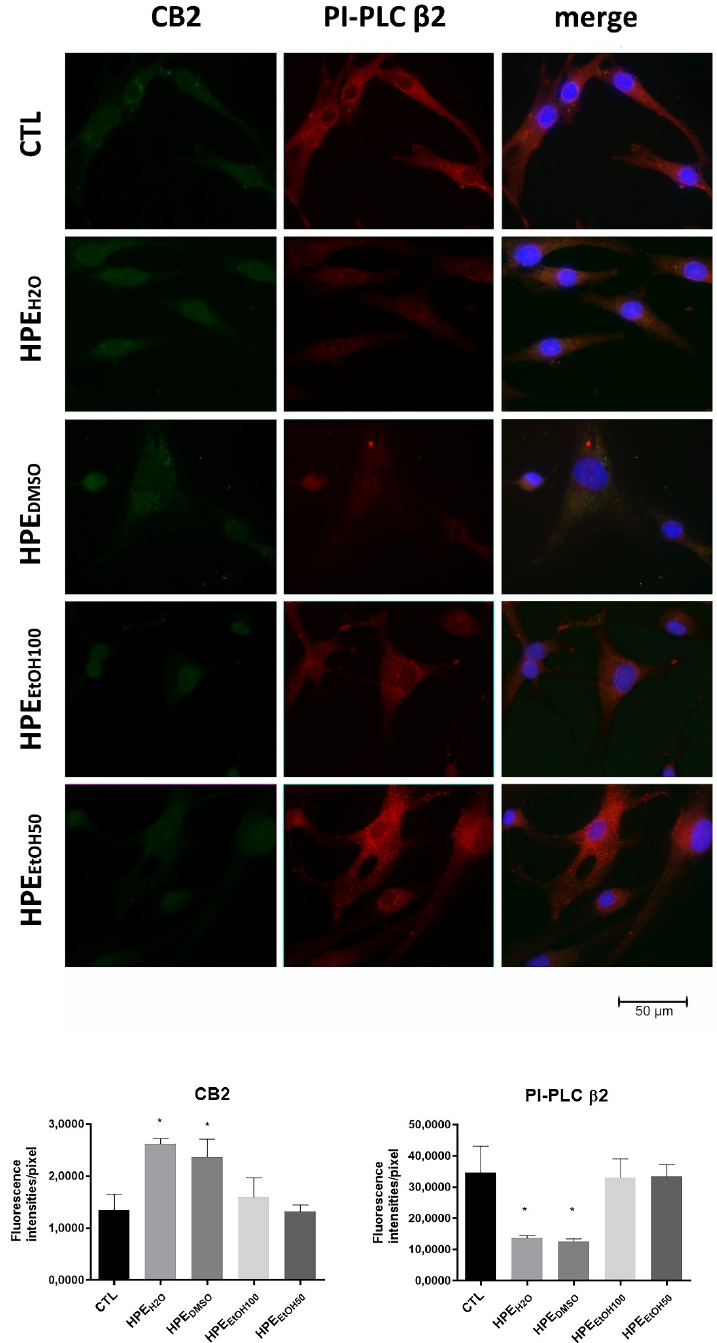
Figure 4. E ff ects of all HPE extracts on CB2 receptor and PI-PLC β 2 protein production. Upper Figure 4. Effects of all HPE extracts on CB2 receptor and PI-PLC β2 protein production. Upper panel: panel: Cells were treated with 0.1 mg / mL of Harpagophytum procumbens root extract (HPE) dissolved Cells were treated with 0.1 mg/mL of Harpagophytum procumbens root extract (HPE) dissolved in in deionized water (HPE H2O ), DMSO (HPE DMSO ), 100% v / v EtOH (HPE EtOH100 ), and 50% v / v EtOH (HPE EtOH50 ), for 24 h and then, analyzed by immunofluorescence using anti-CB2 and anti-PI-PLC β 2 primary antibodies and Alexa Fluor 488 (green, CB2) and Alexa Fluor 568 (red, PI-PLC β 2) secondary antibodies, respectively. Nuclei were stained with DAPI (original magnification 40 × ). Lower panel: The pixel intensities in the region of interest were obtained by ImageJ. * p <